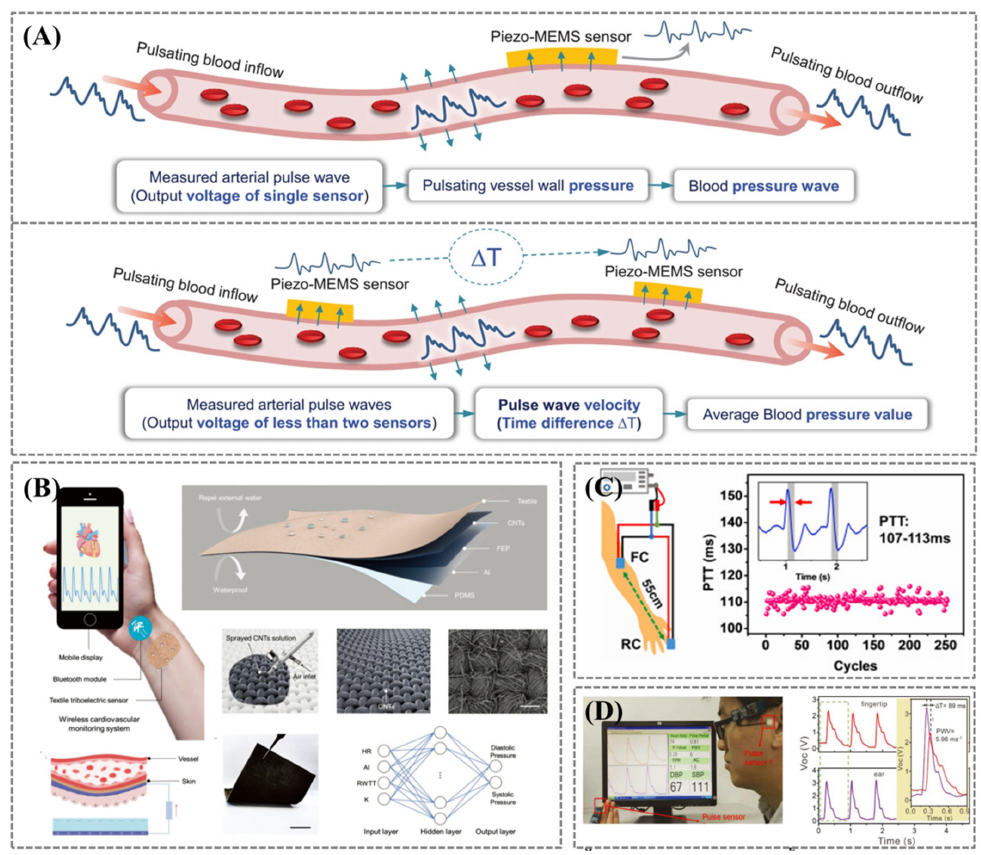
Figure 4. ( A ) The pressure transmission mechanism. Upper (PWA): The correlation between blood pressure waveform and arterial pulse piezoelectric response. Down (PTT): Time difference between two arterial pulse sensors to obtain blood pressure. Reprinted/adapted with permission from Ref. [46]. ( B ) Diagram illustrating a self-powered textile-based triboelectric sensor. The collected signal can be transmitted wirelessly to mobile phones, and the architecture of the supervised feedforward neural network is used for blood pressure prediction. Reprinted/adapted with permission from Ref. [47]. ( C ) Brachial–fingertip PTT and PWV monitoring via the self-powered ultrasensitive pulse sensors (SUPSs). Reprinted/adapted with permission from Ref. [48]. ( D ) A sensor system simultaneously monitors the pulse waves from the human fingertips and ears to read the participants’ PWV and BP values in real time. Reprinted/adapted with permission from Ref.